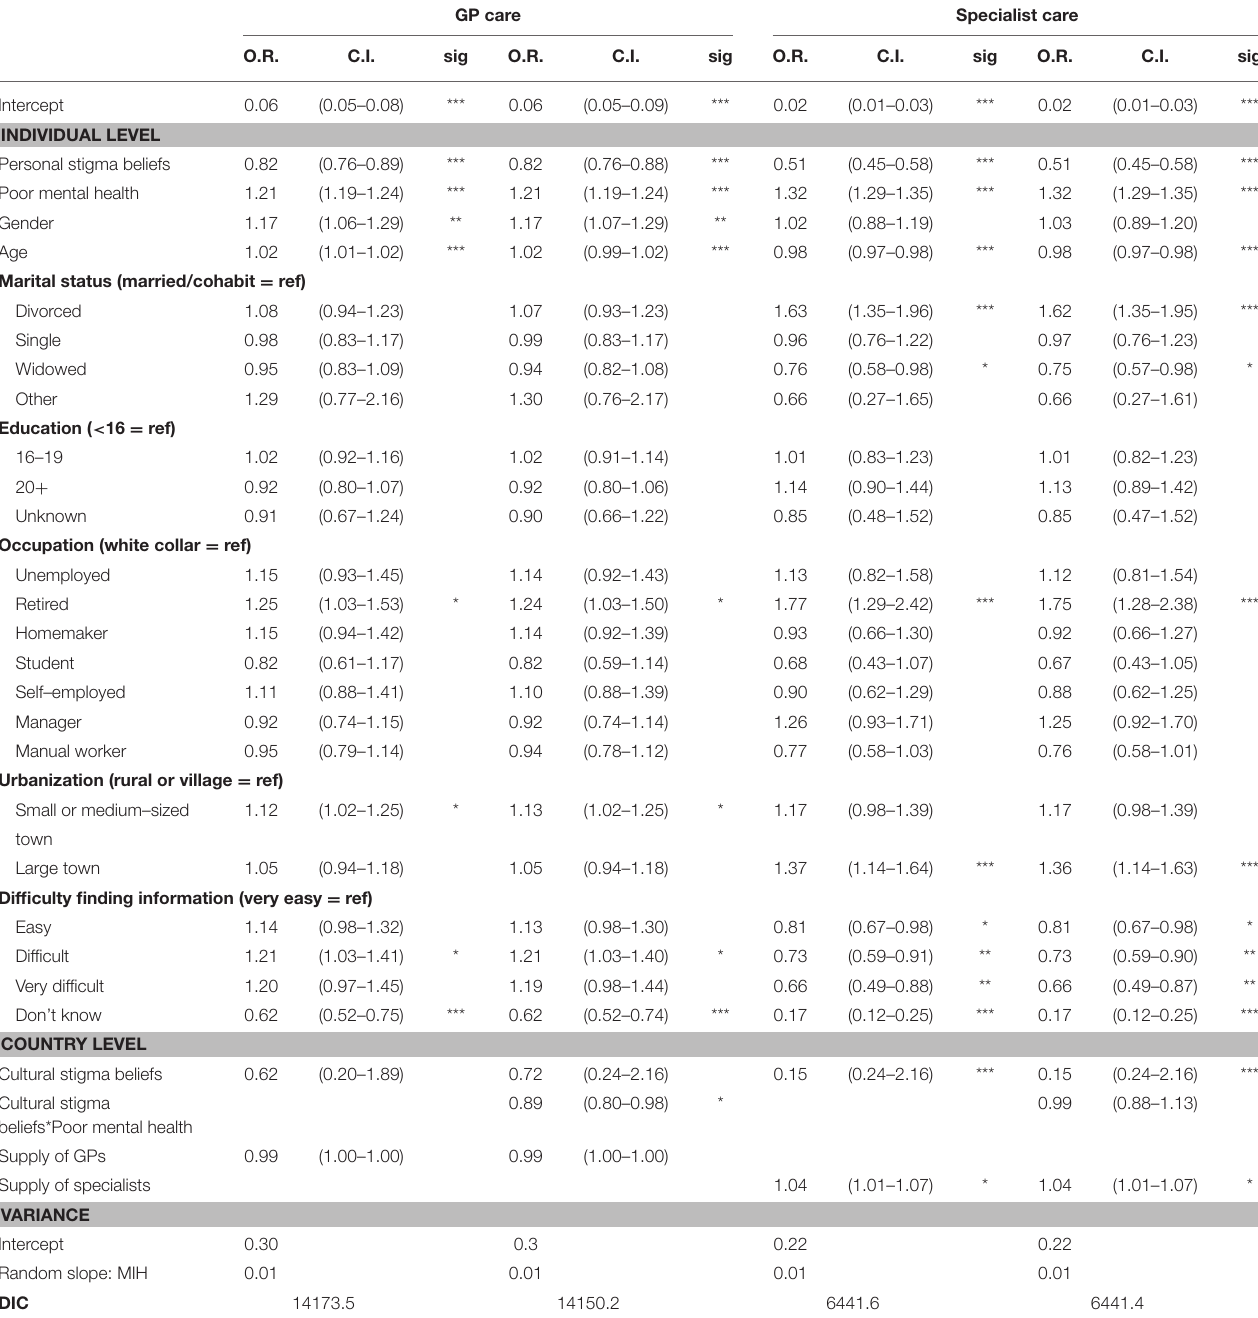
TABLE 1 | Individual and country-level determinants of the utilization of mental health services from general practitioners and specialists (MLwiN logistic regression): odds ratios and 95% confidence